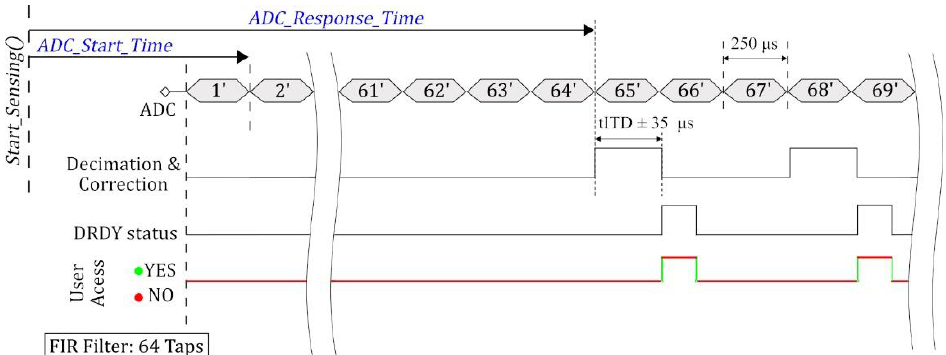
Figure 4. Representative timing diagram for Epson M-A352.